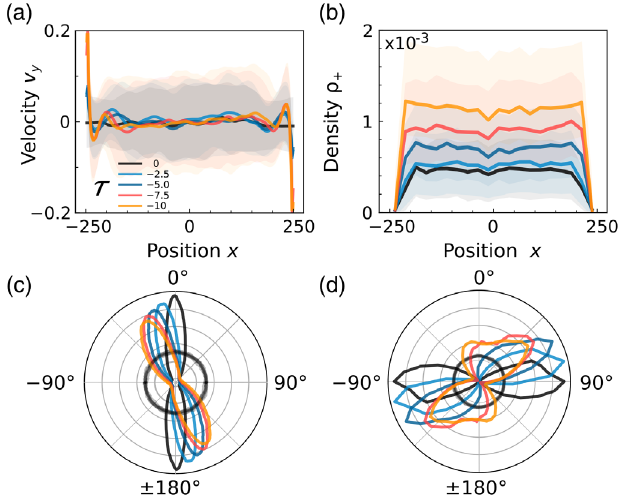
FIG. 4. (a) Average flow for simulated chiral active nematics. The net chiral flow increases in magnitude for increased chiral stress; see Fig. S7 for a close-up [39]. (b) The defect density increases with increased chiral stress. (c) The average tilt of the director close to the boundary increases with increased chiral stress. (d) Average þ 1 = 2 defect orientation close to the boundary. The magnitude of the chiral tilt increases with the chiral stress. Simulation units and parameter values are given in the Appendix.